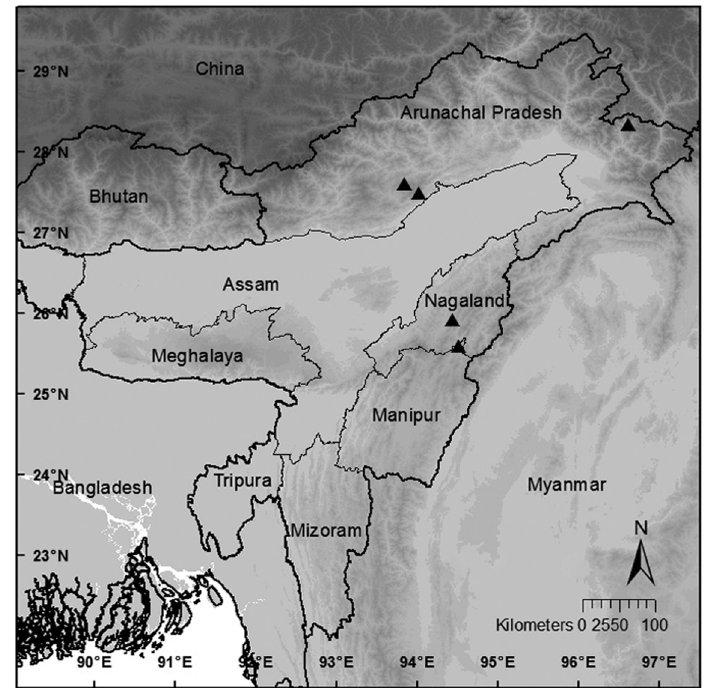
Fig. 24. Map showing the location of B. flaviflora H.Hara